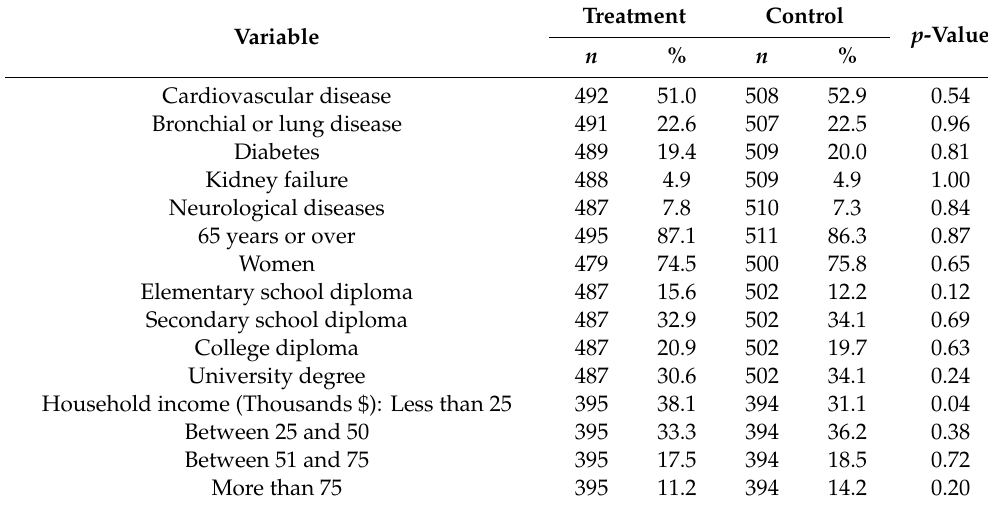
Table 1. Sample characteristics.